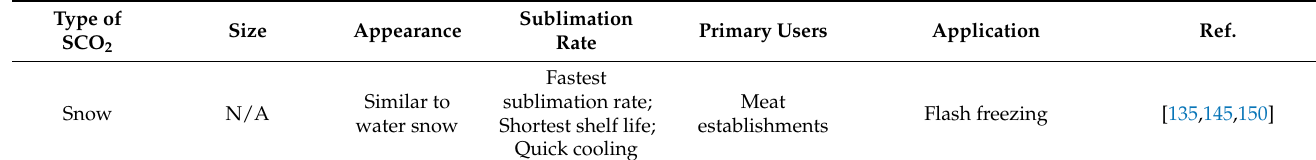
Figure 4. Classification of SCO 2 types according to size, shape, active surface area, and sublimation rate. Table 5. Characteristics of SCO 2